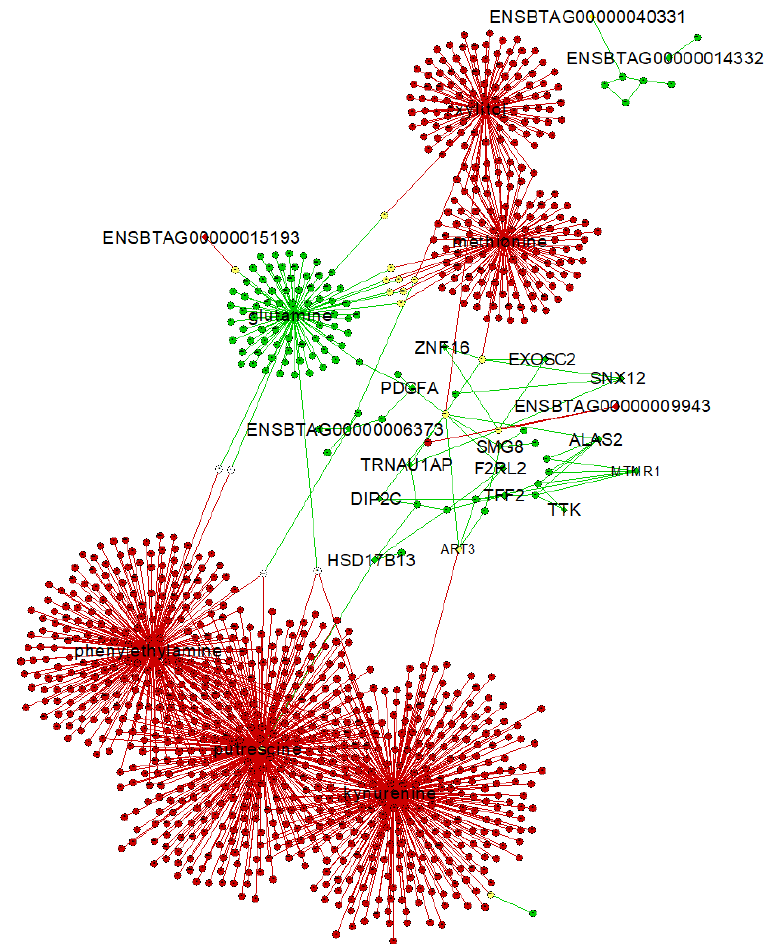
Figure 6. Gene–metabolite interaction network from the AI-P and the NP groups. The unique exclusive targets are highlighted. A central reference network was constructed using DyNet in Cytoscape. The unique nodes are red (AI-P) or green (NP). Shared nodes between AI-P and NP are yellow.